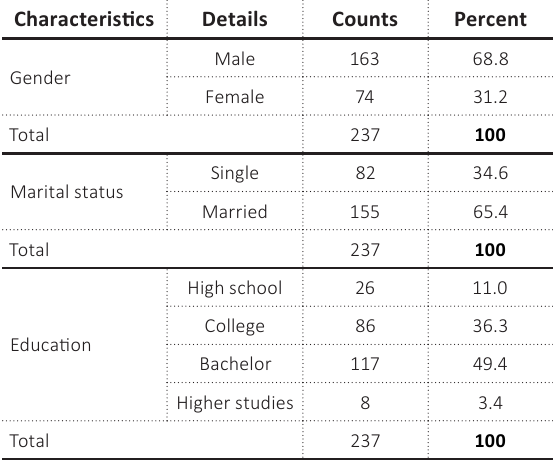
Table 1. Demographic Information